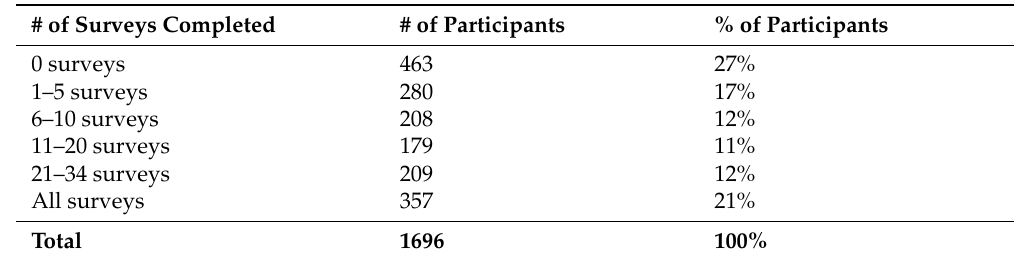
Table 2. Survey completion percentages. The number of surveys completed by each participant ranges from 0 surveys to all 35 surveys.